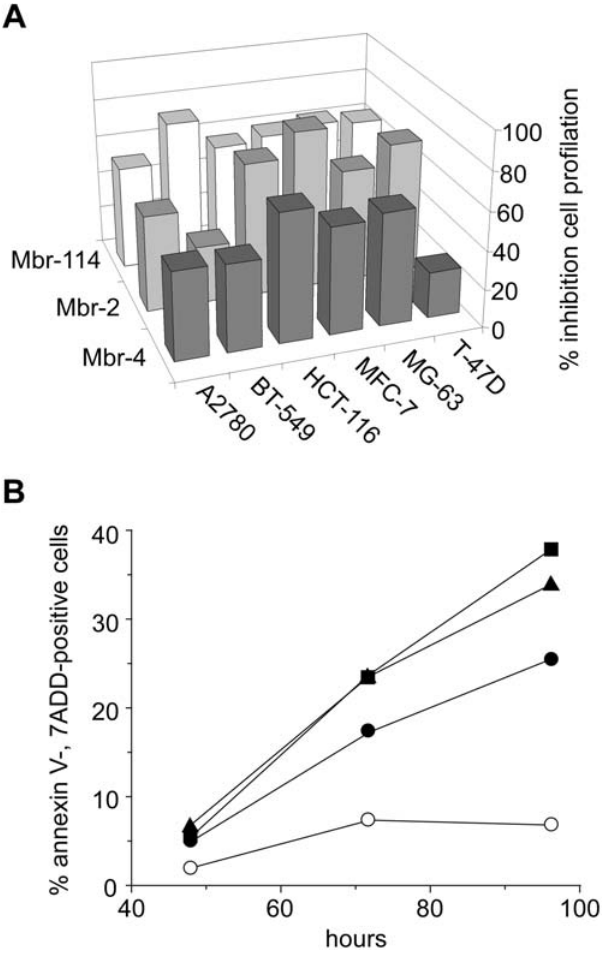
Figure 5. In vitro characterization of anti-TfRC Mbr-4. (a) The indicated cell lines were incubated for 72 hrs at 37 u C with 100 m g/mL of Mbr-2, Mbr-4, Mbr-114 or an isotypic control. Cell viability is reported as percentage of the isotopic control treated cells. (b) HCT-116 cells were incubated for 48, 72 and 96 hrs with 0.8 ( N ), 4 ( & ) and 20 ( m ) m g/mL of Mbr-4 or with an isotypic control ( # ). Cell apoptosis is reported as percentage of Annexin V-, 7AAD-positive cells.